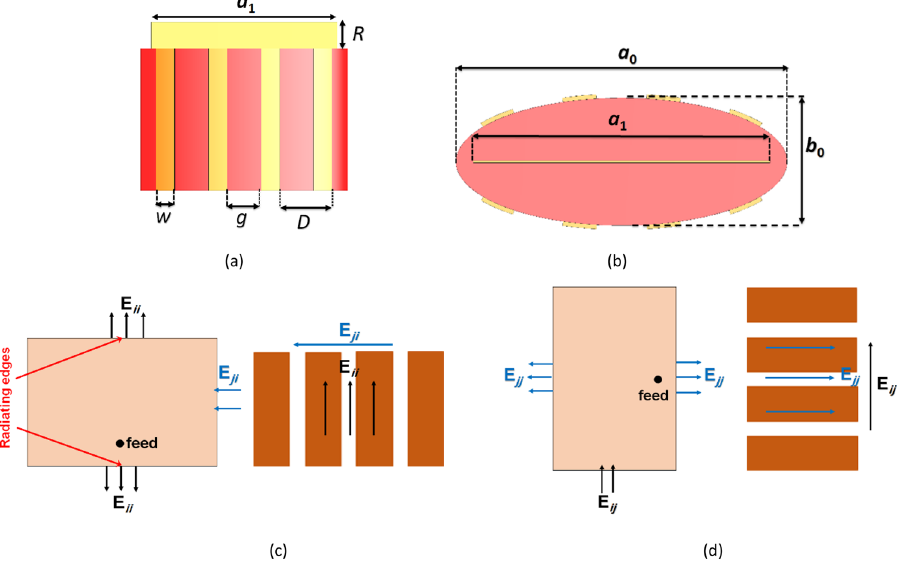
Figure 3. ( a ) Front view and ( b ) side view of the mantle cloak and metasurface strips on the patch antenna. Operating and orthogonal polarizations and the electric fields direction of the ( c ) ith patch and its own cloak strips, ( d ) jth patch and its own cloak strips.